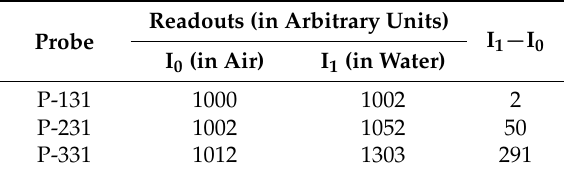
Table 2. Effect of core diameters on sensitivity for the sensor